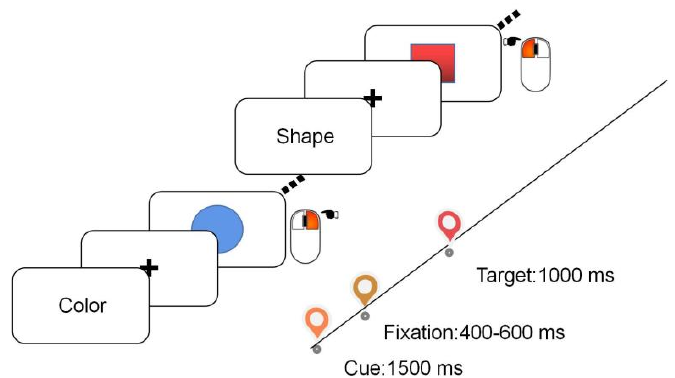
Figure 1. Schematic illustration of the colour-shape task-switching paradigm. Participants respond using a computer mouse.